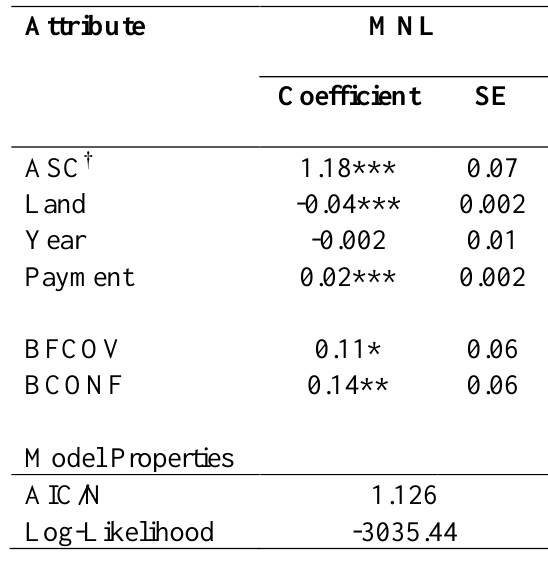
Table A1.4: Estimated beta coefficients from multinomial logit (MNL) model incorporating landowner characteristics of respondents from choice experiment surveys conducted in the buffer area of Pench Tiger Reserve, India in 2018-19. Estimates are from the best-fit model based on